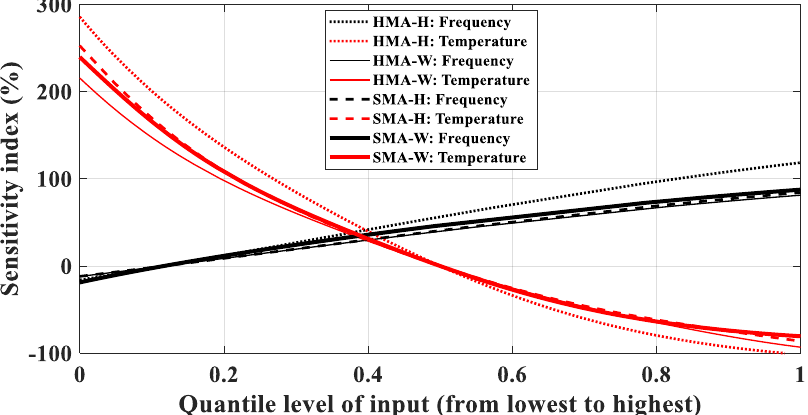
Figure 9. Sensitivity index of frequency and temperature for four combinations of SMA, HMA, H, and W.